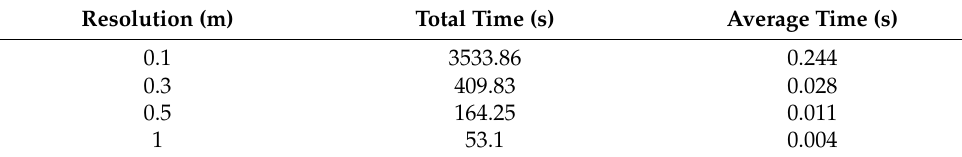
Table 5. The time consumption of the proposed method for dataset 1 under different map resolutions.